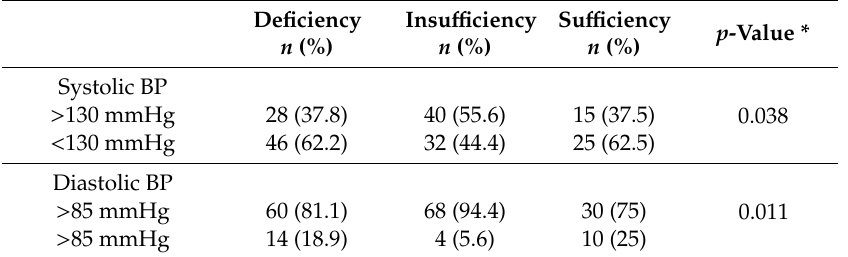
Table 2. Percentage of cardiometabolic risk factors analyzed according to Vitamin D